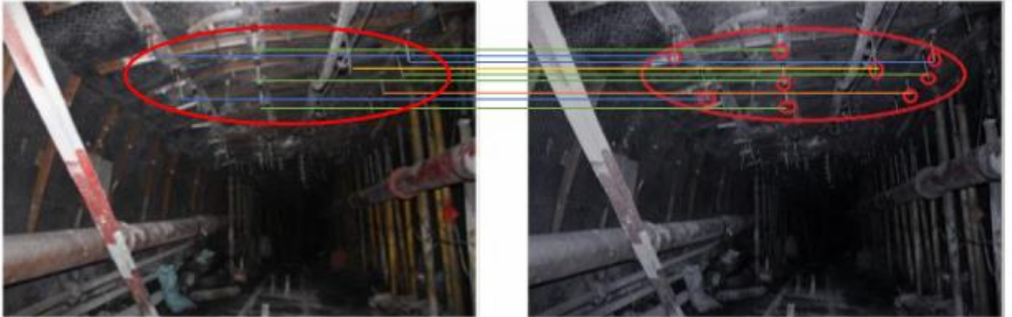
Figure 3. “Anchor protection point cloud”